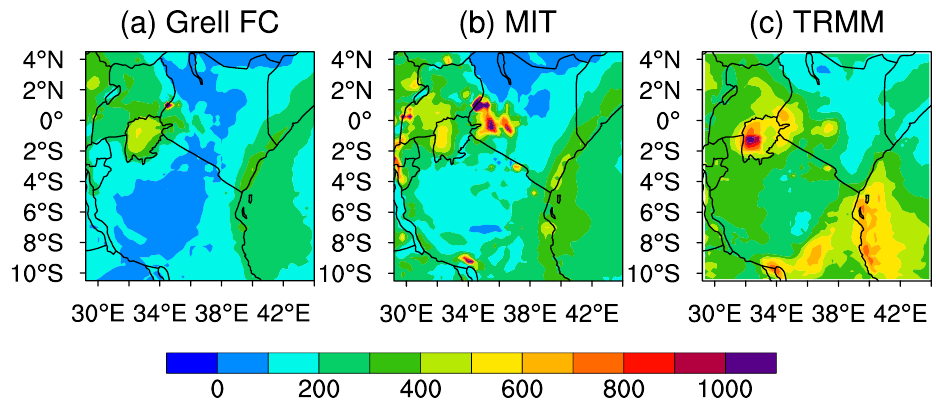
Figure 5. Total seasonal precipitation climatology over East Africa during the Long Rains from 1998–2013 for ( a ) Grell FC, ( b ) MIT-Emanuel, and ( c ) TRMM.